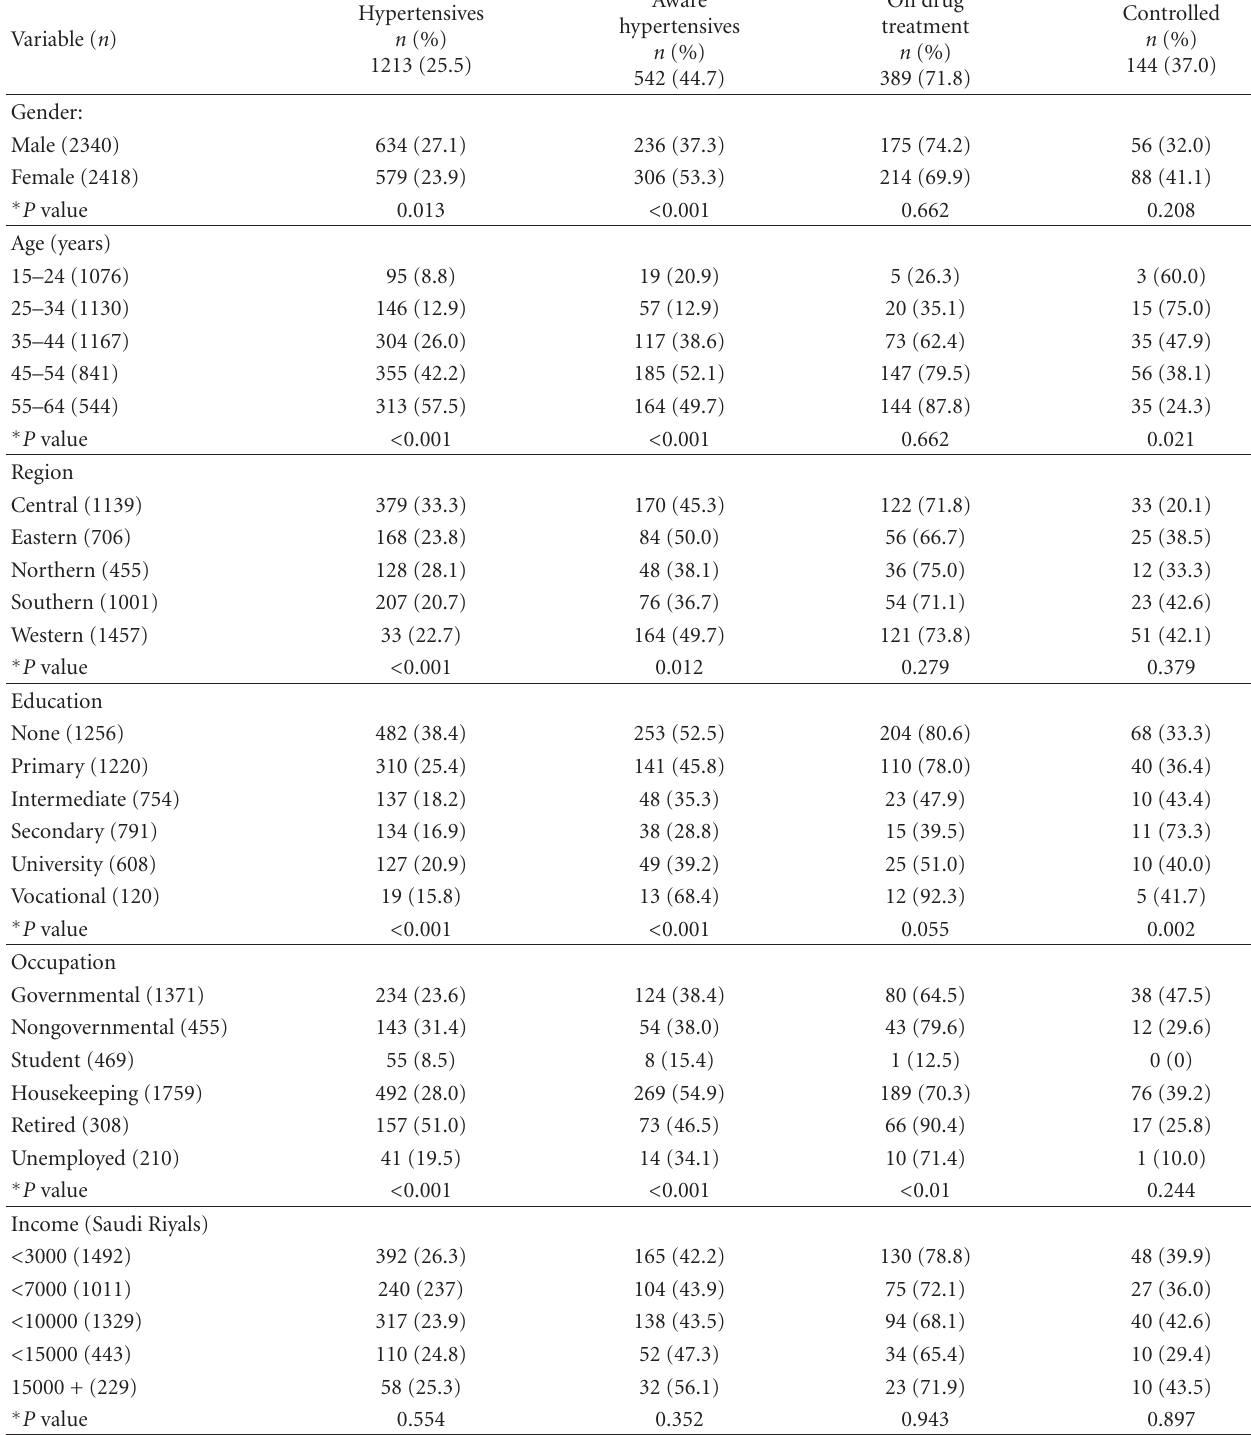
Table 1: Hypertension prevalence, awareness, treatment, and control according to sociodemographic characteristics of subjects ∗